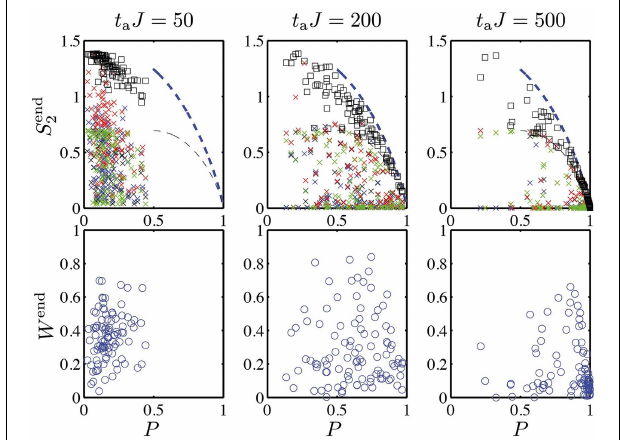
FIGURE 3 | Success probability as a function of final entanglement for different annealing times t a , in a closed system (parameters as in Figure 2). Top : Final entanglement entropy S end 2 of exemplary subsystems of size 2 (crosses). The different colors denote entanglement of the following subsystems with the rest of the chain: (black), (blue), (red), 1 , 2 1 , 3 1 , 16 { } { } { } and (green). When maximized over all possible subsystems containing 12 , 14 { } two sites (black squares), the entanglement entropy lies close to the theoretical FIGURE 4 | Logarithmic negativity E N compared to the optimized upper bound Equation (15) (blue dashed line). The thin black dashed line is the entanglement witness W , for different annealing times t a in a closed bound for a subsystem of length l 1 . Bottom: The optimized entanglement system of N = 16 sites. Top: Comparison of maximal values during the = witness shows a qualitatively similar behavior as the entanglement entropy annealing procedure. Bottom: final values. W provides a rough lower bound S end 2 of typical subsystems. Compared to the maximized S end 2 , however, for E N . While the tendency for these entanglement observables, is to become smaller with increasing t a , in particular for the final values, correlations to the W end shows a larger number of instances with small entanglement, indicating success probability are difficult to find: for all considered annealing times, both that it does not capture all entanglement present in the system. As a result, quantities have a broad available range of maximal and final values. correlations between success probability and W end are washed out.